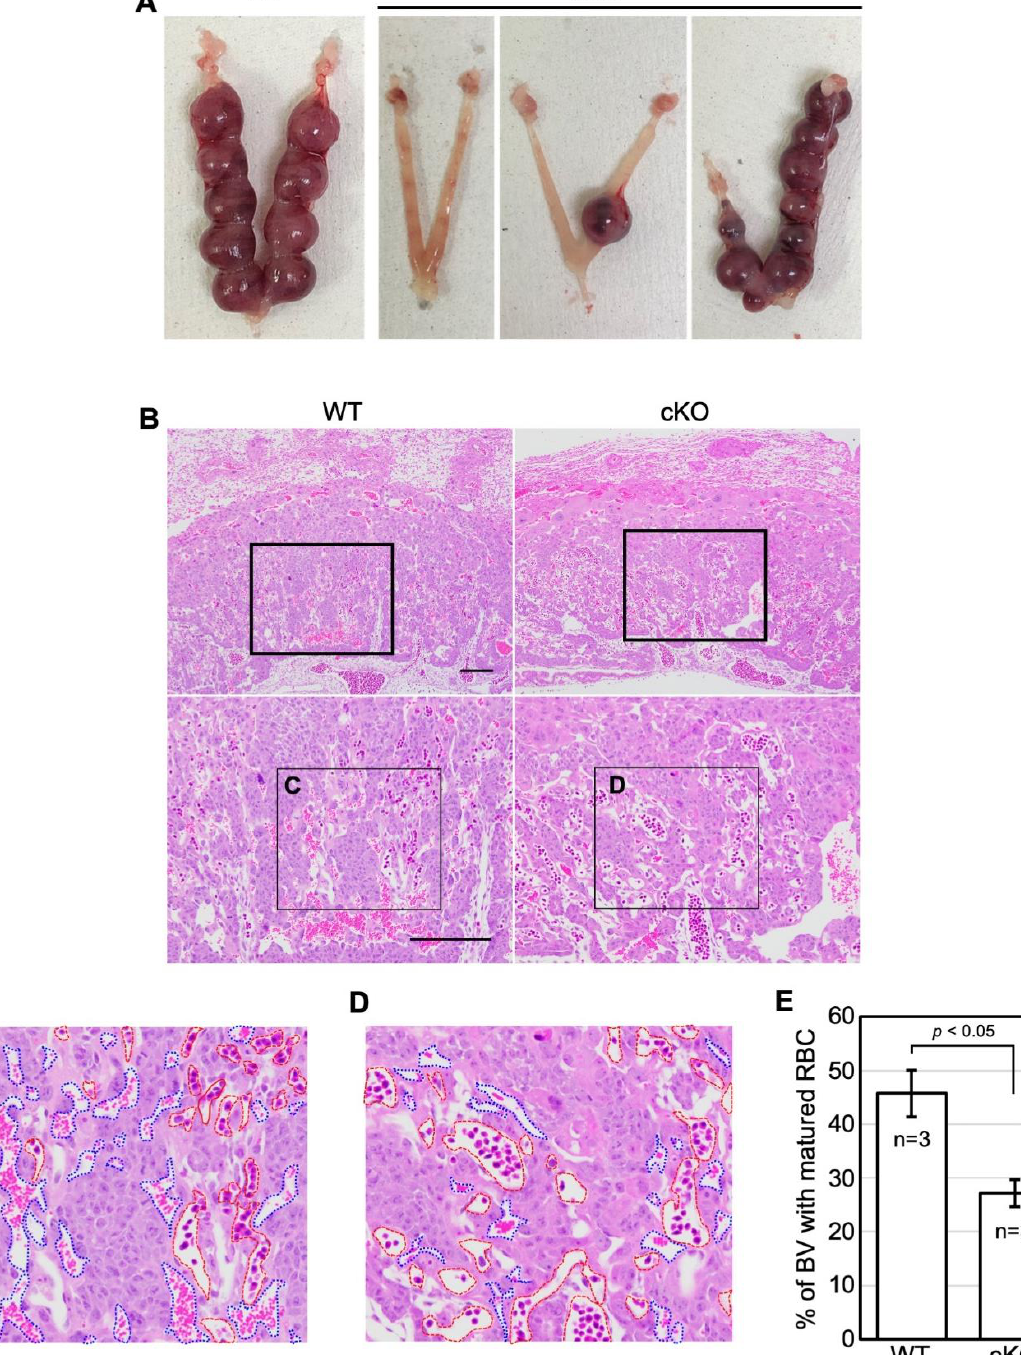
Figure 3. cKO mice show abnormal placental formation on day 12 of pregnancy. ( A ) Representative of uteri from WT and cKO on day 12 of pregnancy. ( B – D ) HE-stained section of the placenta. Blue-dotted areas show maternal blood vessels. Red-dotted areas show fetal blood vessels which contain nucleated erythrocytes. ( E ) The percentage of the maternal blood vessels that contains denucleated red blood cells (RBC). The bar shows SE. Differences in the ratio of calculated areas of maternal vessels between the wild-type and cKO mice were analyzed by the unpaired t- test. p < 0.05. The scale bar shows 100 µm.